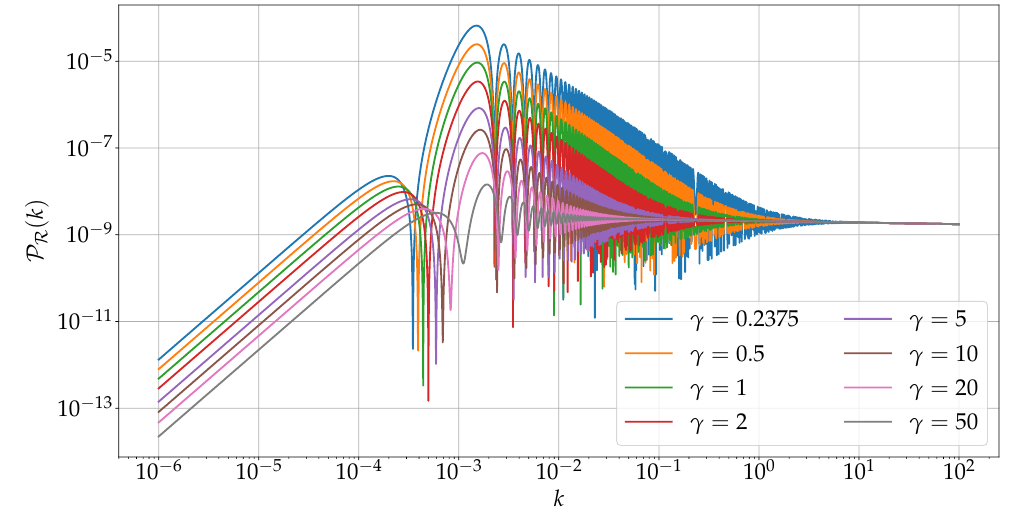
Figure 12. Primordial scalar power spectrum of the 0th-order adiabatic state in hybrid LQC for values of the Immirzi parameter between 0.2375 and 50. The background solution was studied in Section 5.